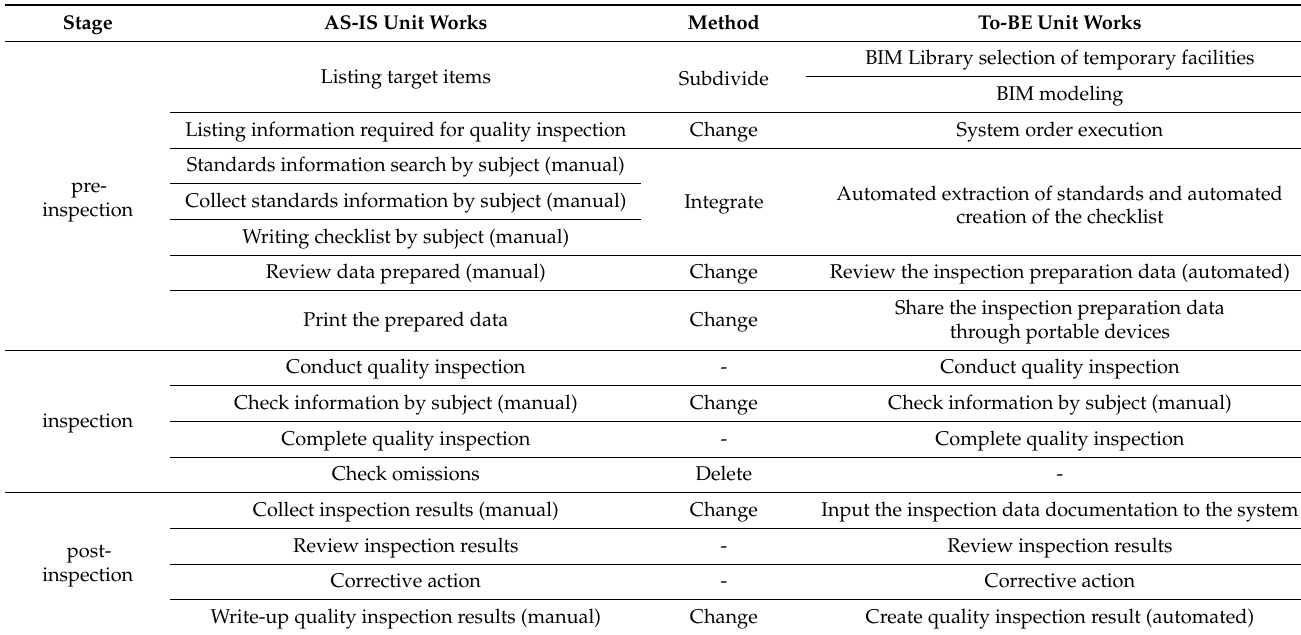
Table 3. Organization of TCW quality inspection unit